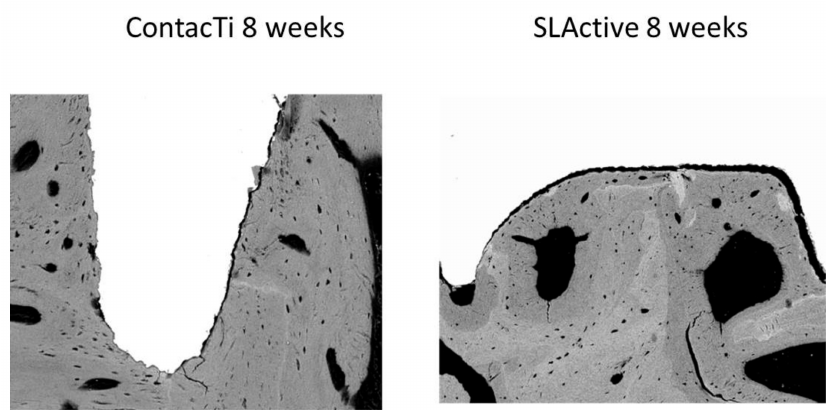
Figure 2. Histological images of the ContacTi ® and SLActive ® surfaces obtained by SEM in a maxillary section at 8 weeks, at 150 × magnification.